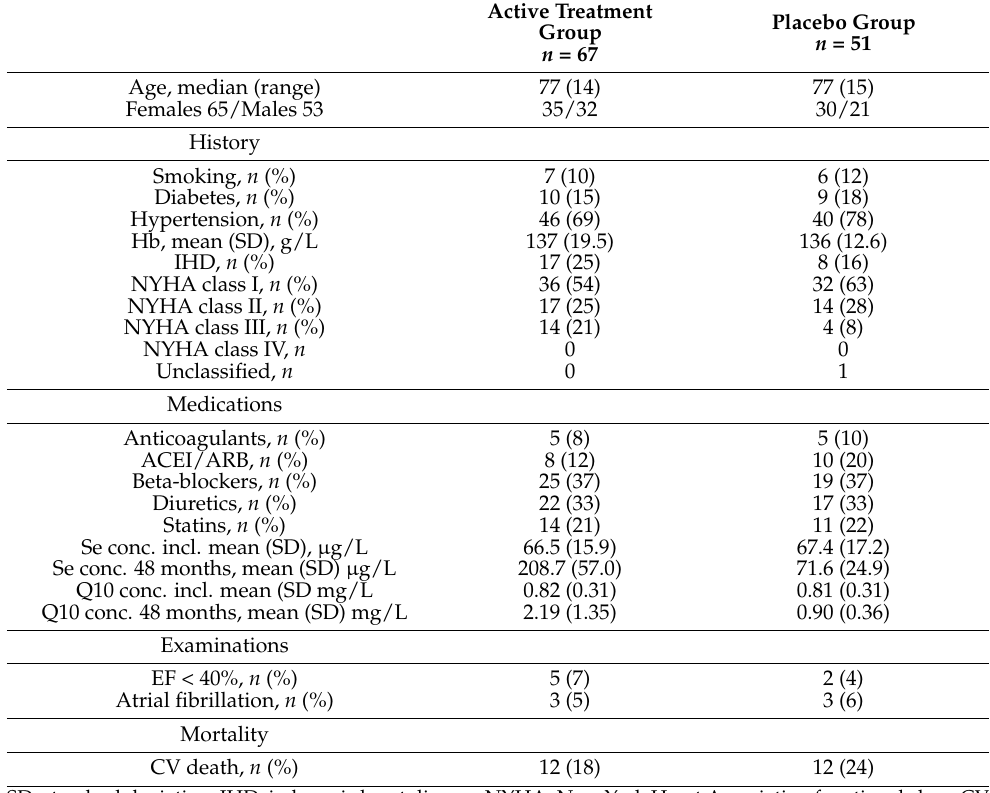
Table 1. Baseline characteristics of the study population receiving Se and coenzyme Q 10 supplemen- tation or